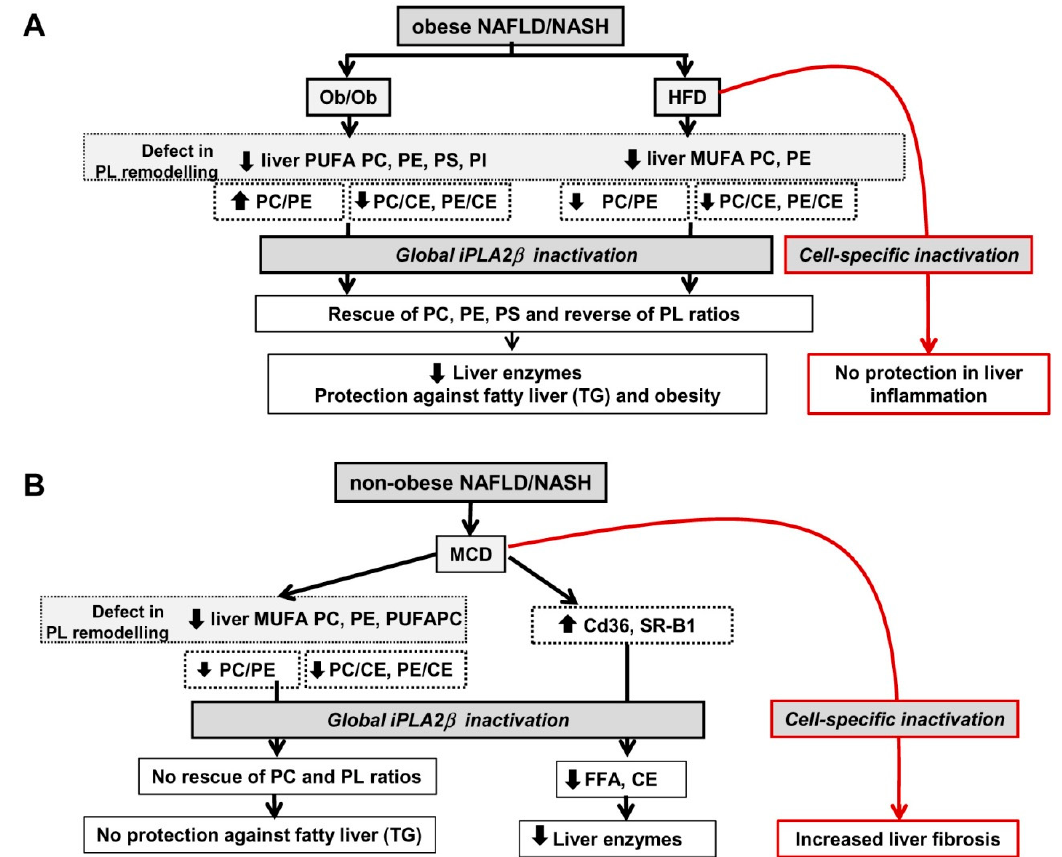
Figure 9. Role of iPLA 2 β deficiency in obese and non-obese NAFLD / NASH mouse models. ( A ) Livers of genetic Ob / Ob and chronic HFD-fed mice exhibited a defect in PL remodeling with suppressed contents of PUFA PLs. PC / PE ratio was increased in Ob / Ob mice while that of HFD-fed mice was decreased. iPLA 2 β inactivation replenished PLs associated with fatty liver protection. ( B ) Livers of